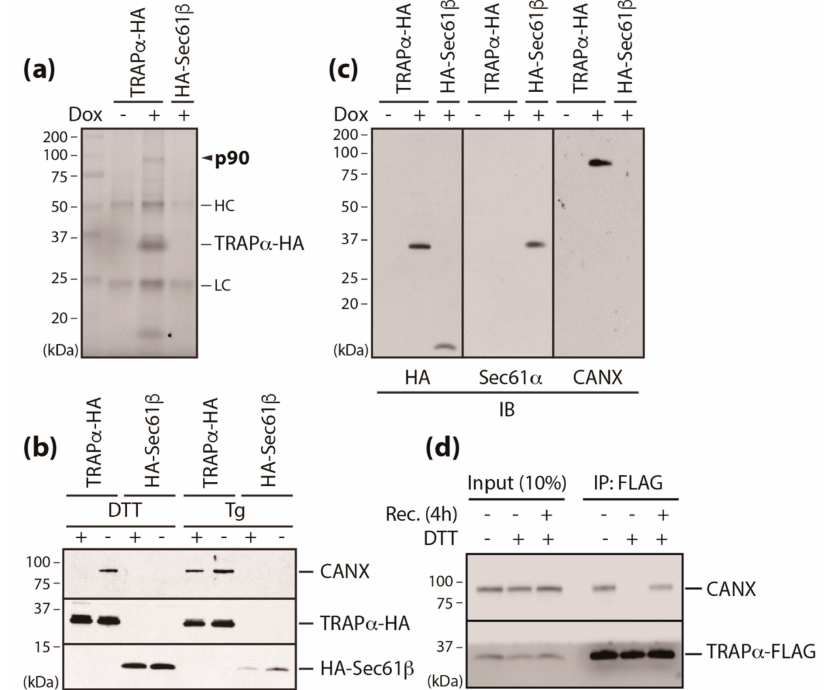
Figure 2. Redox-sensitive interaction of calnexin and translocon-associated protein (TRAP) α ( a ) TRAP α complexes were recovered with anti-HA magnetic beads from detergent-solubilized microsomes isolated from stable / inducible cells expressing TRAP α -HA after doxycycline treatment (Dox; 10 ng / mL). HC: immunoglobulin heavy chain, LC: immunoglobulin light